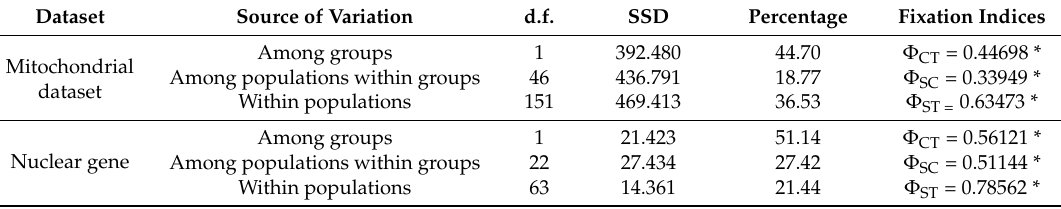
Table 2. Hierarchical analysis of molecular variance (AMOVA) based on mitochondrial and nuclear datasets.